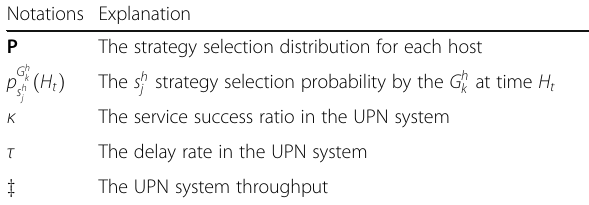
Table 1 Parameters used in the proposed algorithm